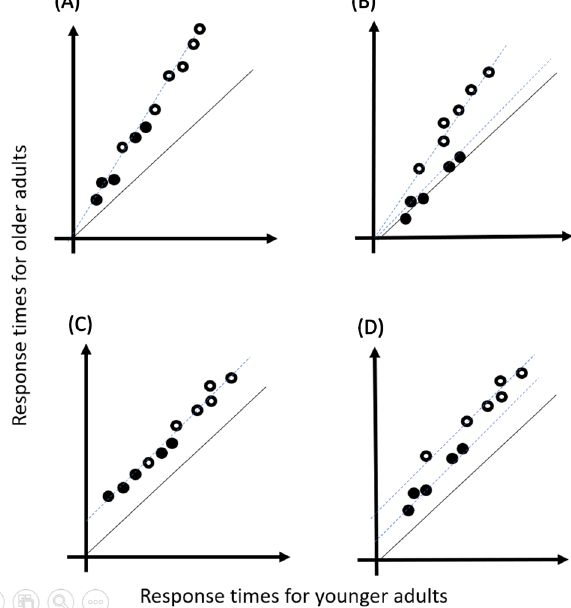
Figure 2. The hypothetic plots for possible results of the Brinley plot. The hypothetic data for the non-overlap condition (the easier condition) were marked with black dots and that for overlap condition (the more difficult condition) were white dots. The diagonals of the plot were marked with black while the fitted regression lines were marked with dotted blue lines. ( A ) Multiplicative complexity, equivalent processing speed for both conditions. ( B ) Multiplicative complexity, less efficient processing for overlap than non-overlap conditions. ( C ) additive complexity, equivalent processing stages, and ( D ) additive complexity, some additional processing stages for overlap than non-overlap